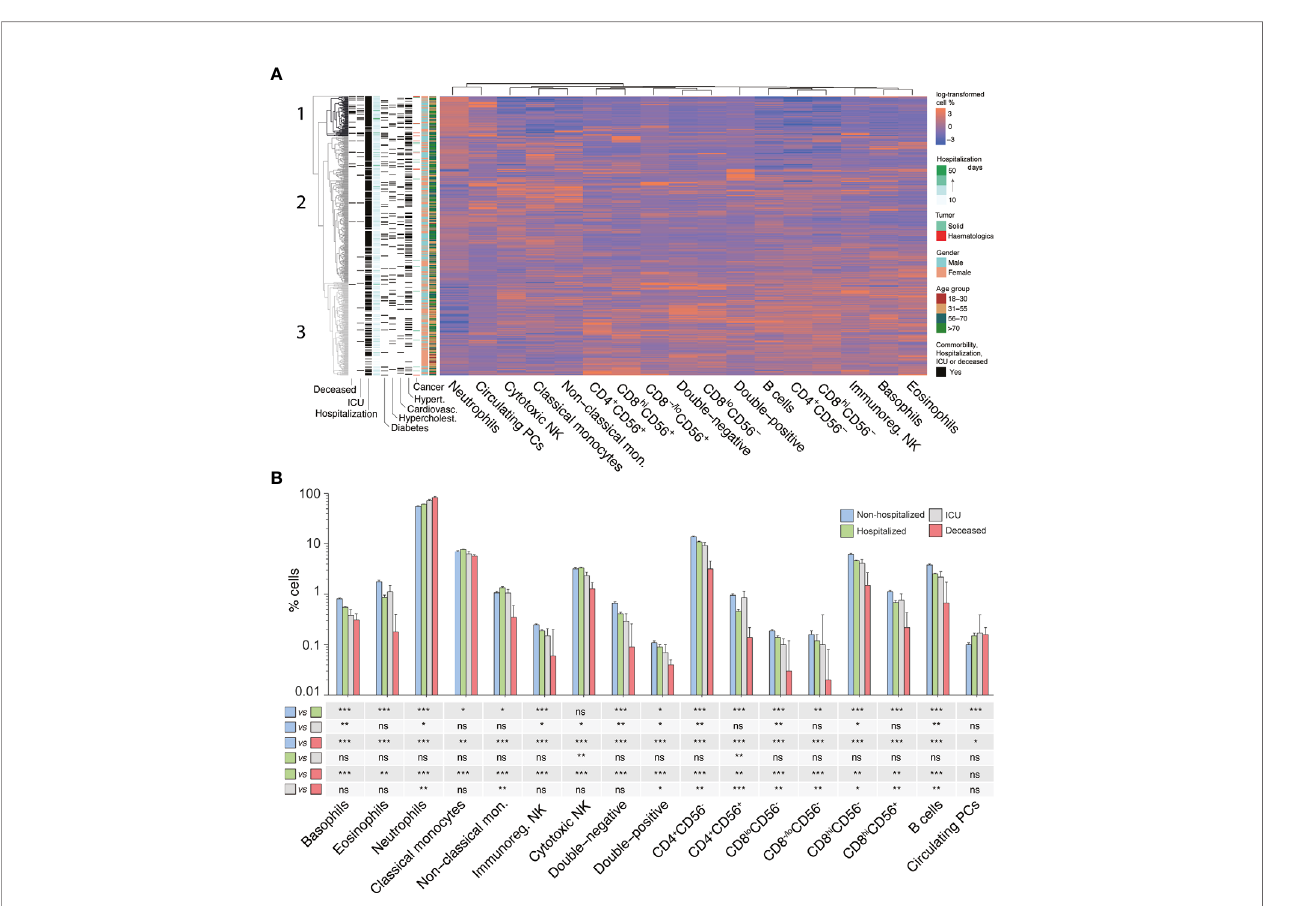
FIGURE 3 | The immune landscape of patients with COVID-19 and its association with disease severity. (A) Unsupervised clustering of 513 patients with COVID-19 based on the relative distribution of 17 immune cell types in peripheral blood (PB) samples taken at presentation. For the columns to the left of the cell-percentage data, moving from right to left, patient rows are color-coded according to age and gender; green and red marks indicate the patients with solid or hematological tumors; dark gray marks indicate the presence of the comorbidities of hypertension, cardiovascular disease, hypercholesterolemia, and diabetes; light blue-to-green marks indicate duration of hospitalization; and dark gray marks indicate patients requiring hospitalization (n=395), patients who needed intensive care unit (ICU) admission (n=32), and patients who died (n=23). (B) Median percentages of the 17 immune cell-types in PB samples from patients with COVID-19 who were not hospitalized (n=118) and those who required hospitalization (n=395), as well as the subsets of hospitalized patients who required ICU admission (n=32) and/or who died from COVID-19 (n=23). * P <0.05; ** P <0.01; *** P <0.001; ns, not signi fi cant. Statistical signi fi cance was evaluated using Mann – Whitney